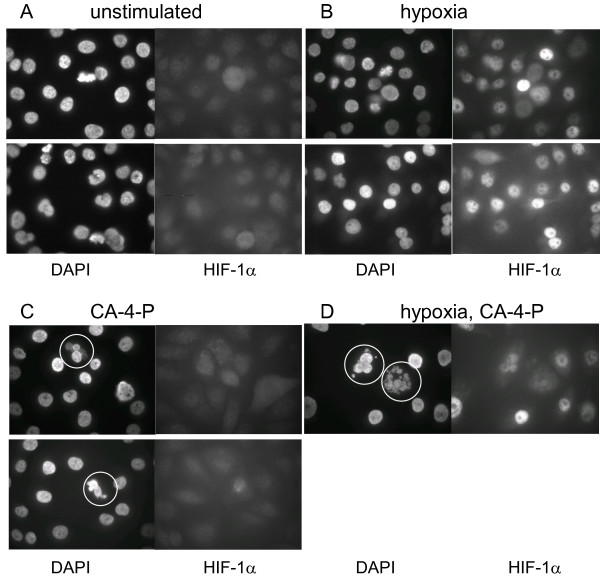
Effect of CA-4-P on cellular HIF-1 localisation and nuclear morphology. Immunofluorescent staining showed limited nuclear HIF-1 accumulation of unstimulated T24 cells (A) and CA-4-P-treated aerobic cells (C), with significant accumulation in hypoxic (B) and CA-4-P-treated hypoxic cells (D). CA-4-P treatment (1 μM) induced nuclear fragmentation (circled), but did not notably alter HIF-1 localisation. Identical microscopic fields of DAPI-stained nuclei (left) and HIF-1α stained cells (right) are shown.